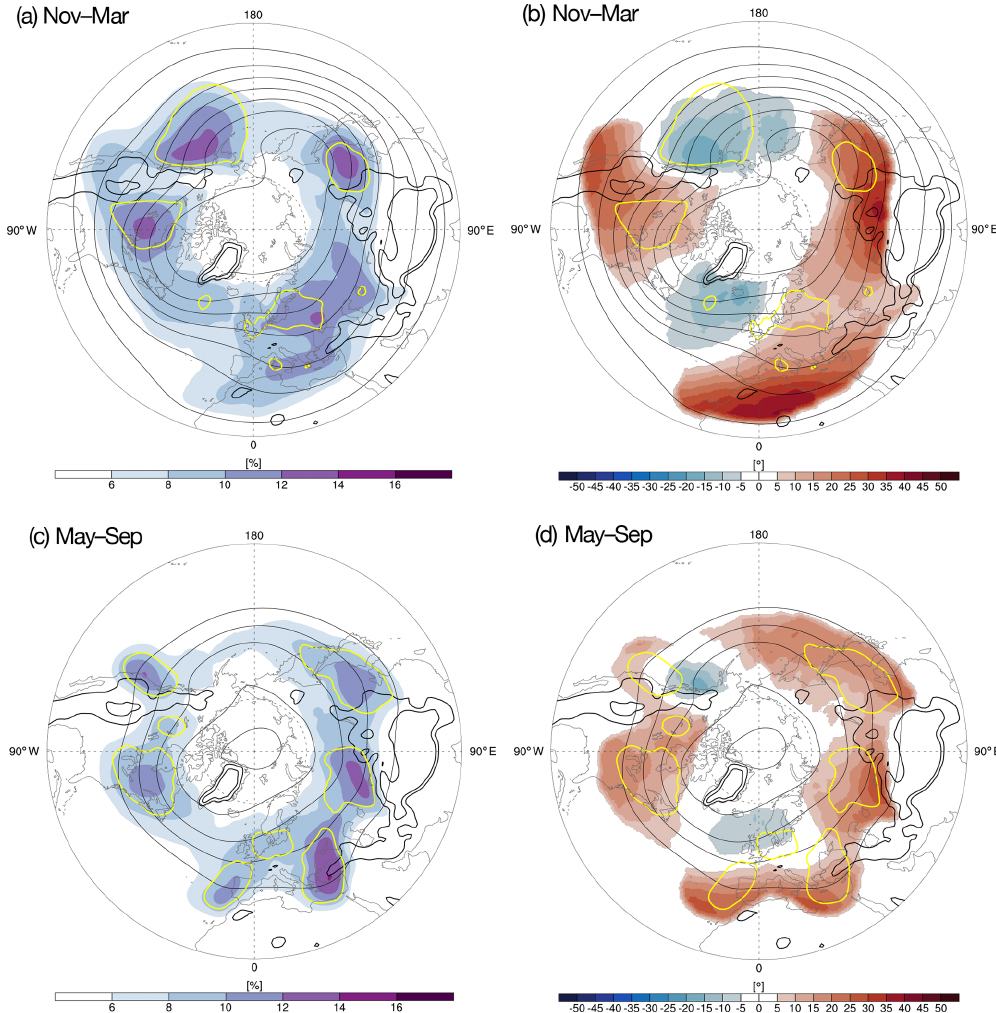
Figure 4. (a, c) Seasonal climatologies of the trough detection frequencies (color shading; units: %) for the cold ( a ; November–March) and warm ( c ; May–September) seasons. Additional contours show selected frequencies of troughs with an age between 0 and 24h (yellow). (b, d) Seasonal climatologies of the corresponding horizontal trough orientation at the 500hPa level (color shading; units: degrees) for the cold ( b ; November–March) and warm ( d ; May–September) seasons. Positive values indicate anticyclonically oriented troughs. Additionally, the yellow 0–24h age contour, similar to that in (a, c) , is shown for reference. The 1500m height contour (black) is shown in all the